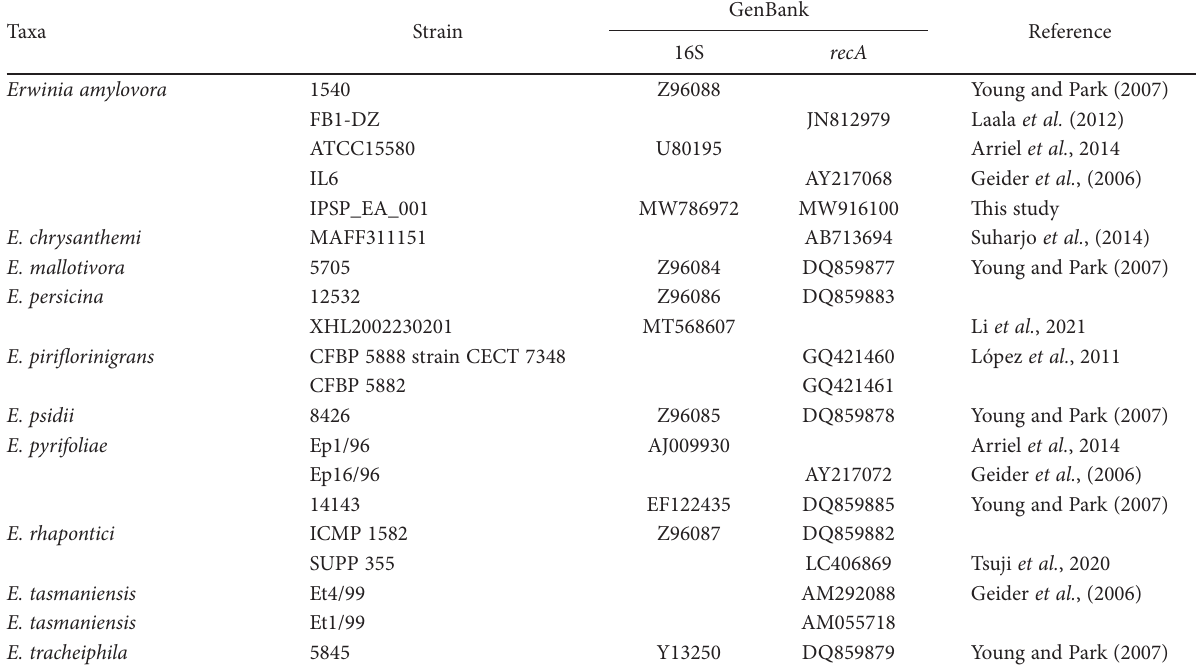
Table 1. Isolates of Erwinia species used in this study. Sequence numbers in bold font were obtained in the present study.